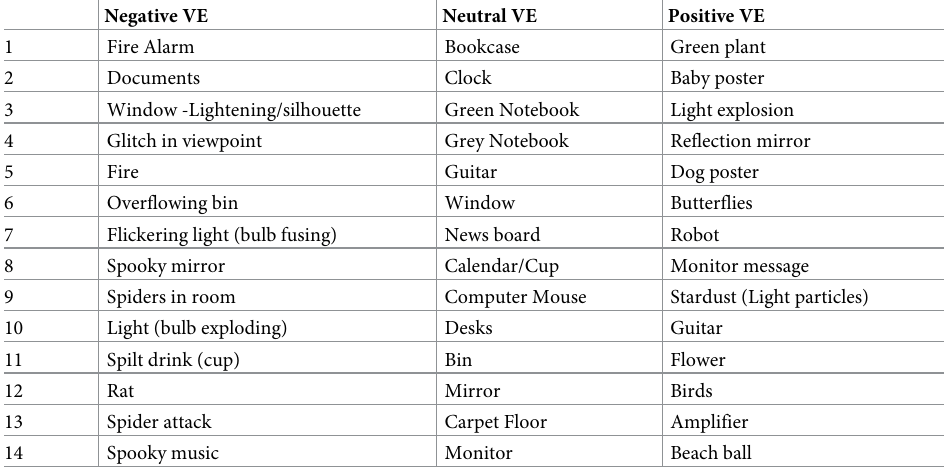
Table 1. List of objects and events for each office